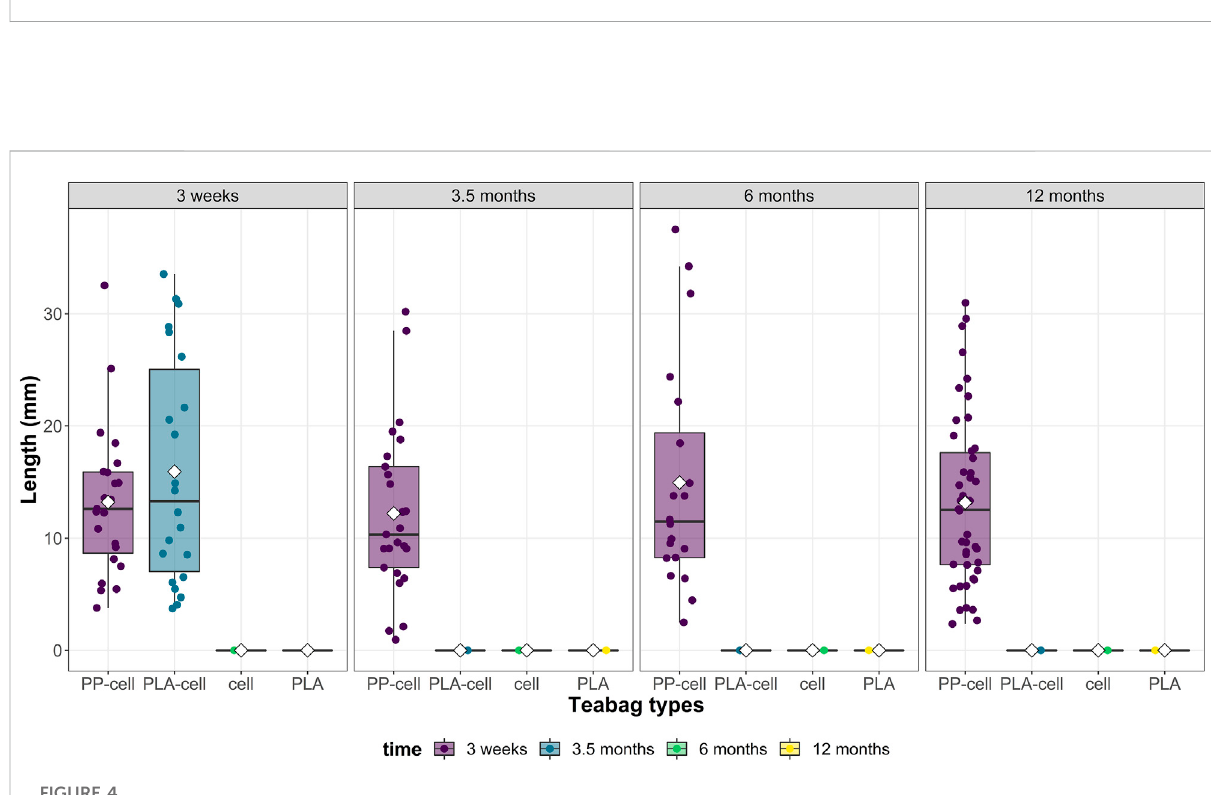
FIGURE 4 Total number of fragments in terms of size from the four teabag types across time points.